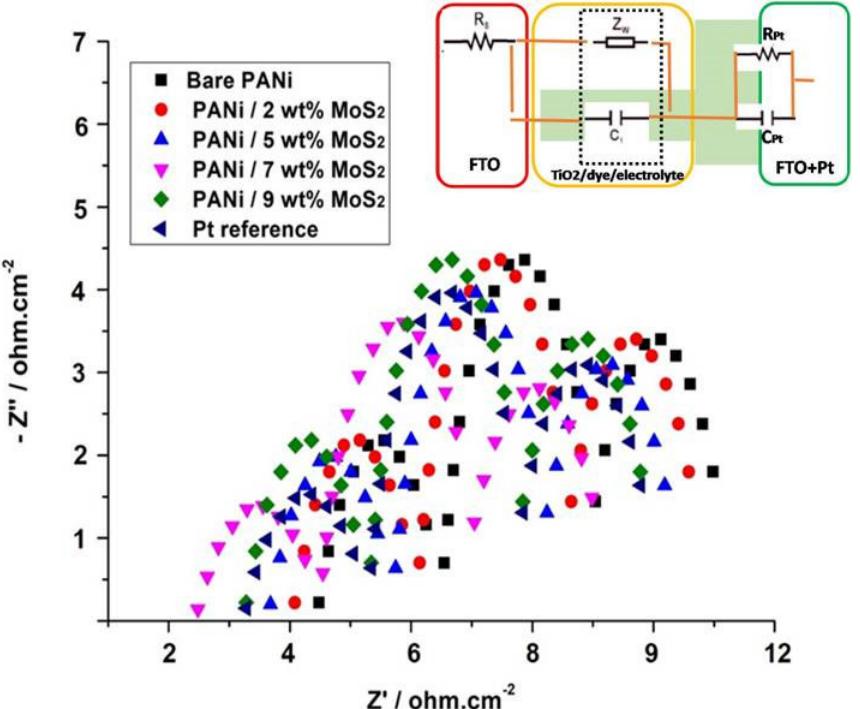
Figure 5. EIS pattern of specimens under investigation.